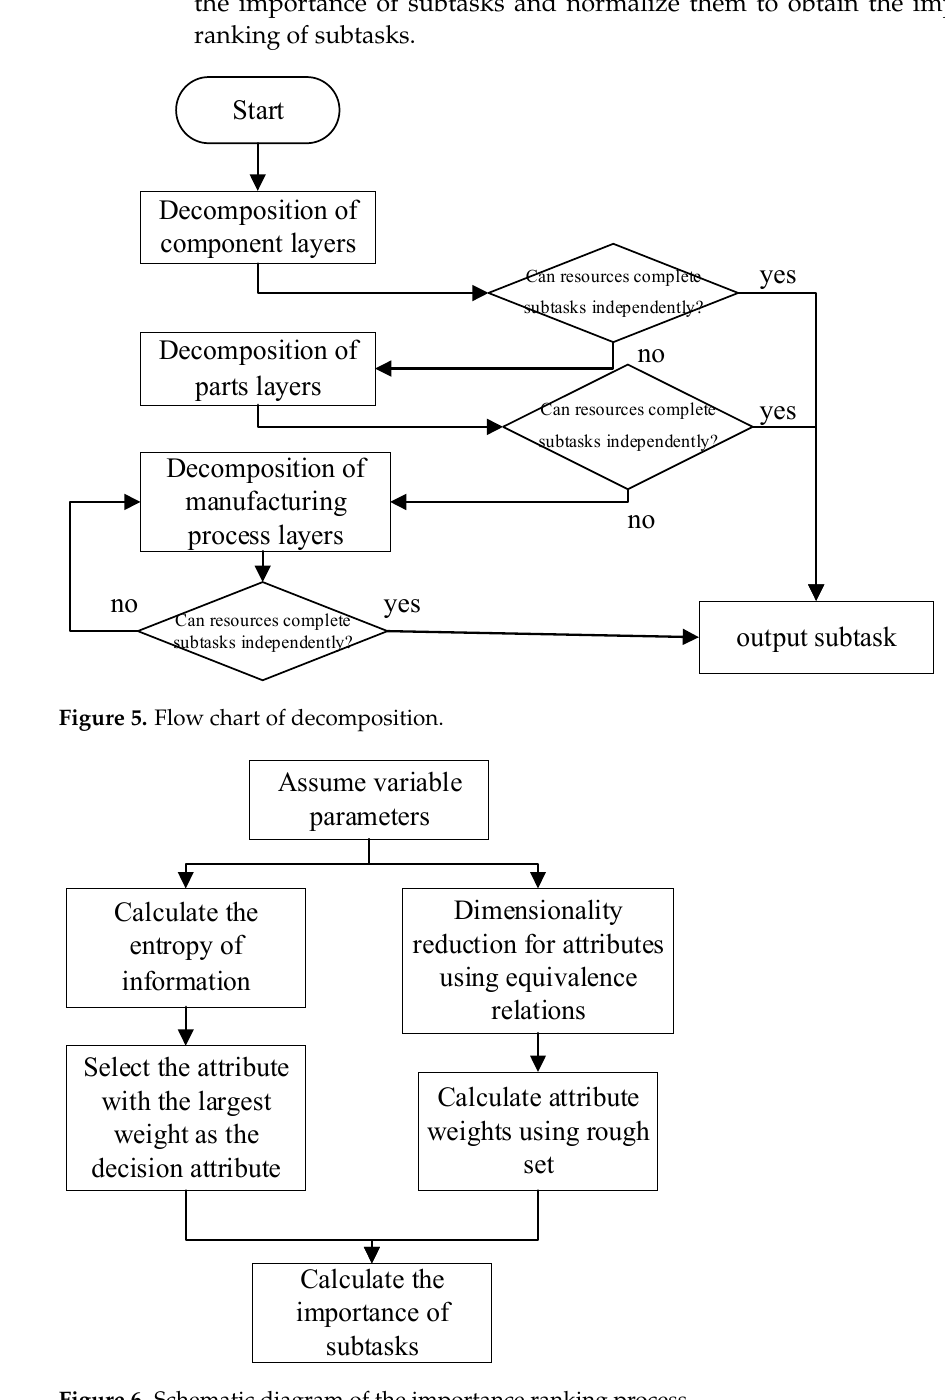
Figure 6. Schematic diagram of the importance ranking process.